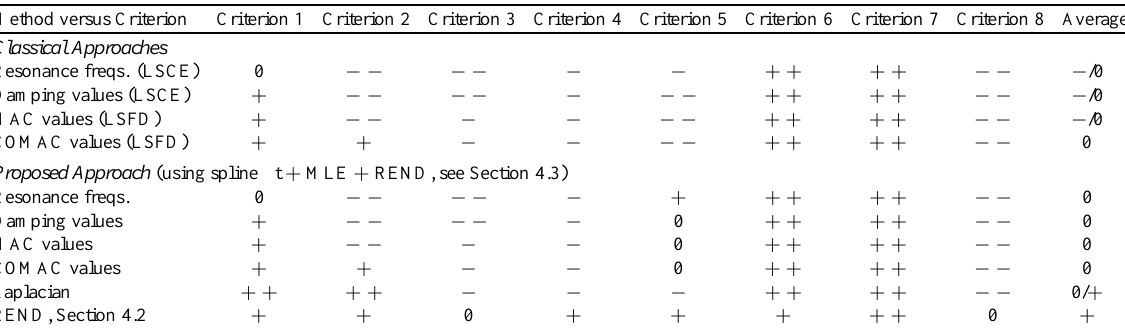
Table 1 Overview of performance criteria for different techniques (see Section 2 for the criteria descriptions), based on the test included in the